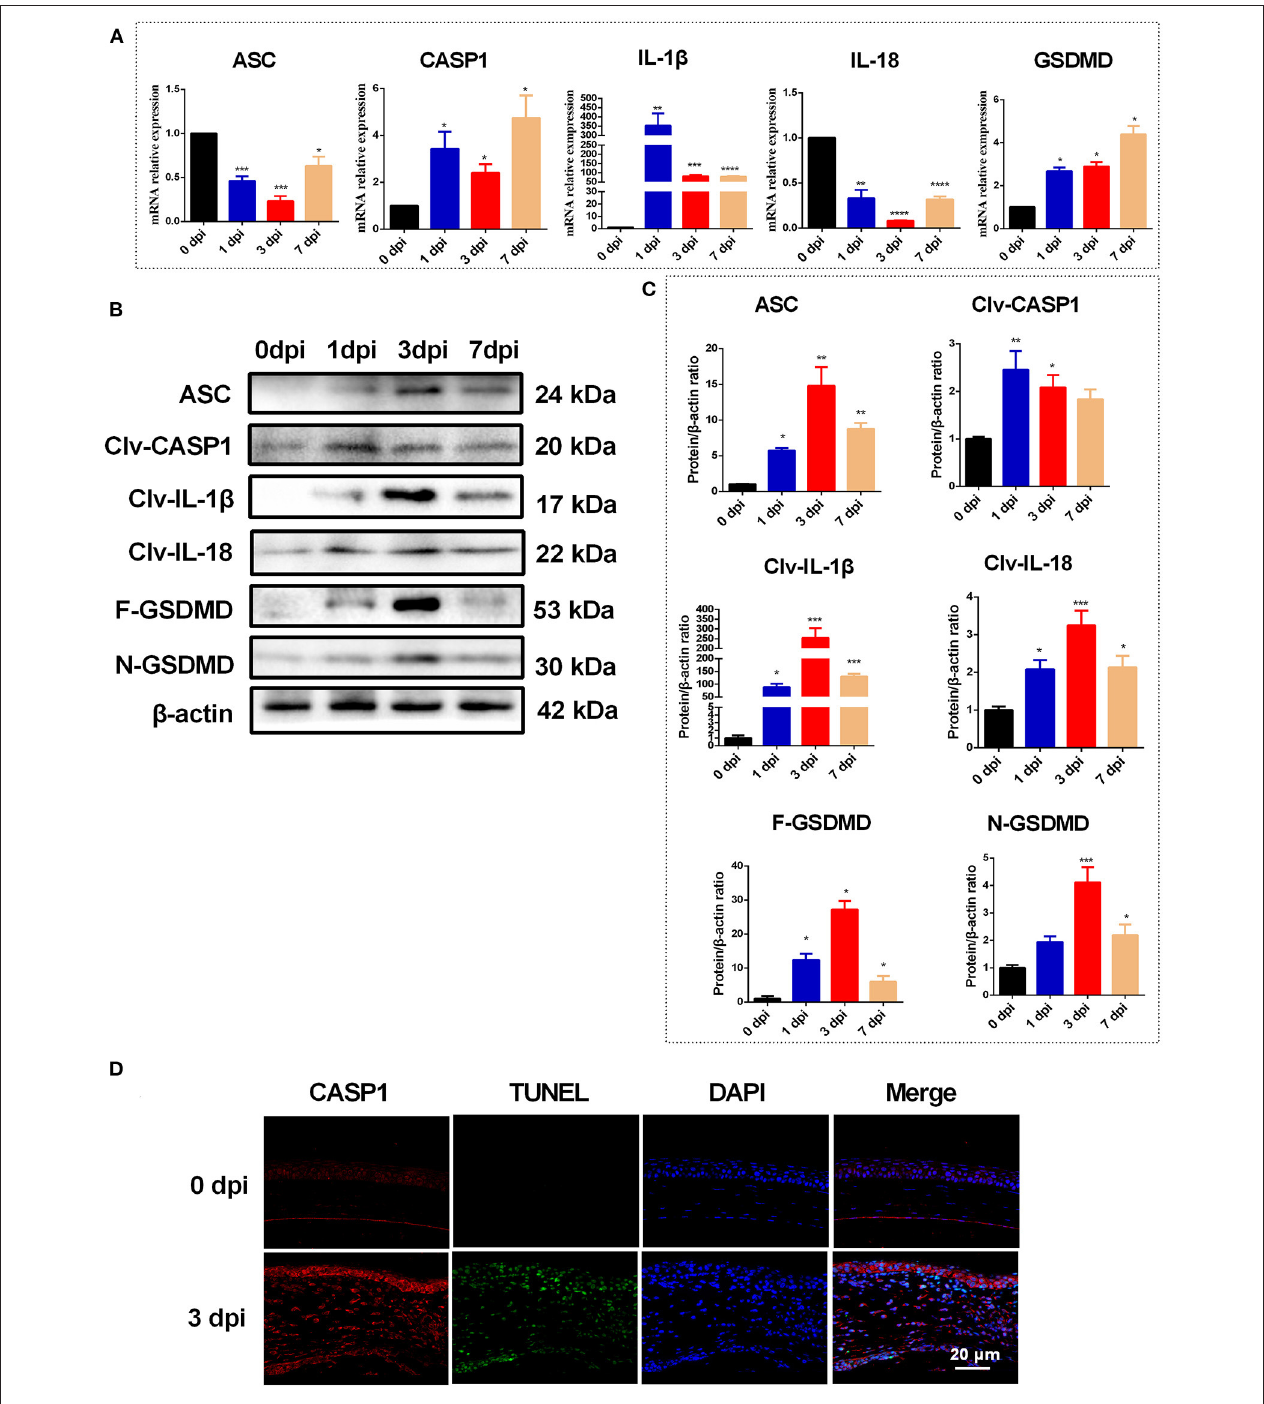
FIGURE 2 | Pyroptosis is occurred in mouse corneas of C. albicans keratitis. (A) RT-qPCR analysis of the mRNA levels of pyroptosis-associated genes (ASC/CASP1/GSDMD/IL-1 β /IL-18) in mouse corneas at 0 (control), 1, 3, and 7 dpi ( n = 3). (B,C) Western blot detecting pyroptosis-related proteins of ASC, cleaved CASP1, cleaved IL-1 β , cleaved IL-18, F-GSDMD and N-GSDMD in mouse corneas at 0 (control), 1, 3, and 7 dpi ( n = 3). (D) Double-immunofluorescence staining of CASP1 and TUNEL in C. albicans infected-corneas compared with mock-infected controls ( n = 3; Scale bar = 20 µ m; magnification 400 × ). CASP1: caspase-1; Clv-CASP1:cleaved CASP1; Clv-IL-1 β :cleaved IL-1 β ; Clv-IL-18:cleaved IL-18; F-GSDMD: p53 form of GSDMD; N-GSDMD: cleaved p30 form of GSDMD. All values are presented as mean ± SEM. * p < 0.05; ** p < 0.01; *** p < 0.001; **** p < 0.0001 vs. control group.